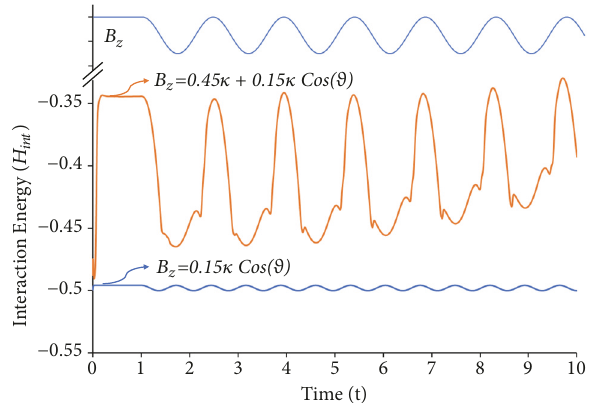
Figure 4: Temporal distribution of interaction energy densities of cubic superconducting sample in the magnetic field of types (A) 𝐵 = 0.45𝜅 + 0.15𝜅 cos 𝜃 and (B) 𝐵 𝑧 of side 20𝜉 each, with parameters 𝜅 = 4 and 𝜎 = 1 .